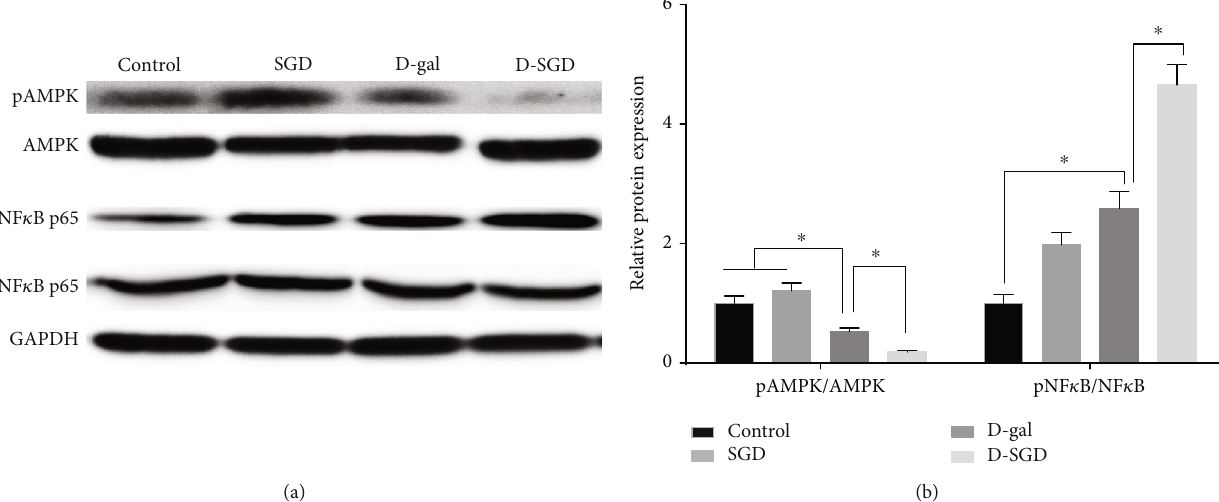
Figure 3: E ff ects of serine de fi ciency on AMPK and NF κ B expression in D-galactose-treated mice. (a) Protein expression of AMPK, pAMPK, NF κ B p65, and pNF κ B p65; (b) Relative expression of pAMPK and pNF κ B p65 according to the results of (a). Data were expressed as mean ± SEM , n = 3 . ∗ P < 0 : 05